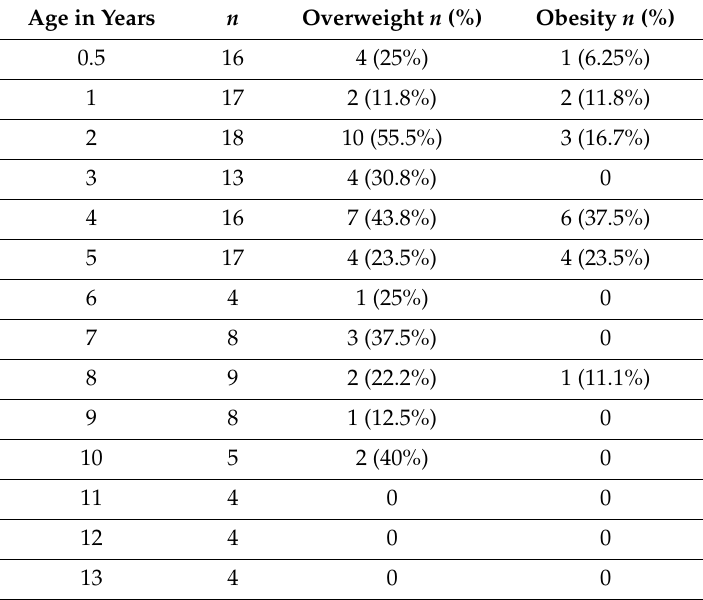
Table 1. Rate of overweight and obesity in pediatric patients with